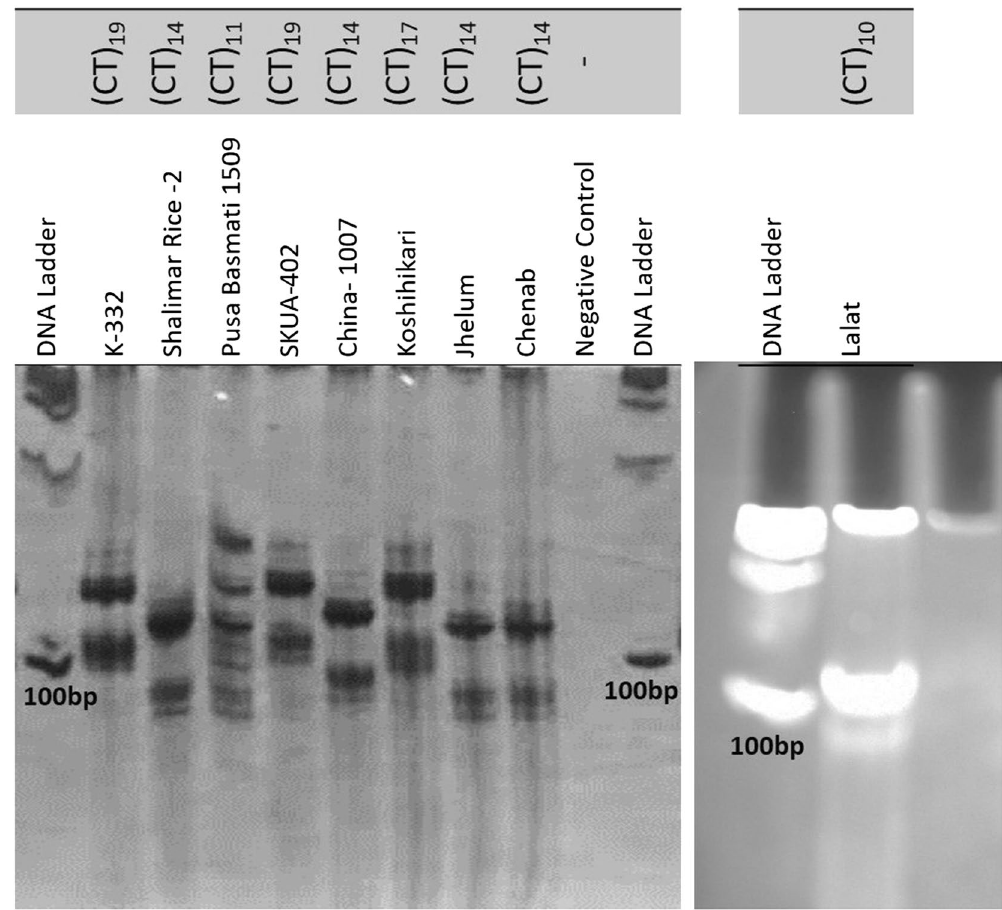
Figure 1. Allelic variation within Waxy gene among rice genotypes at RM190